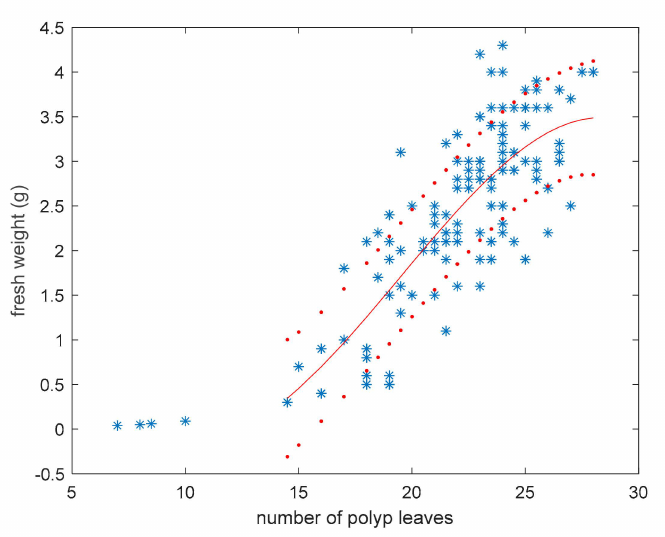
Figure 5. Fresh weight vs. the number of polyp leaves in Pennatula rubra ; red curve is the third-degree polynomial fitting experimental data, and red dot curves include 95% of